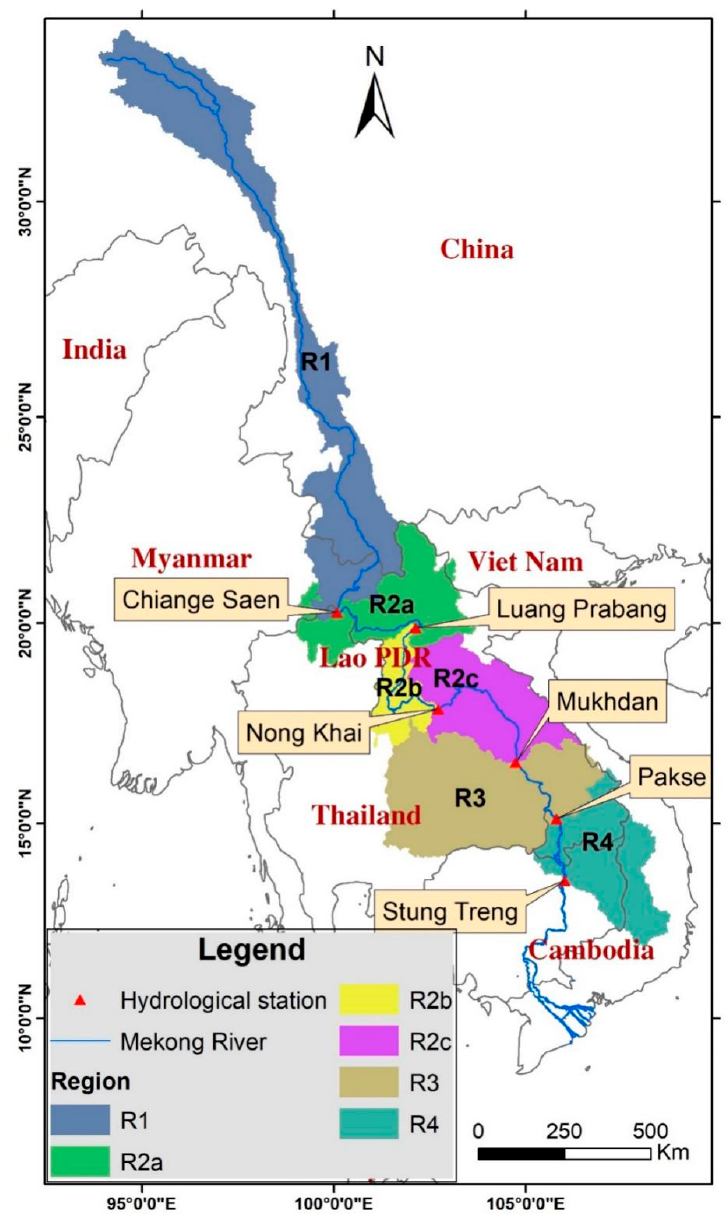
Figure 7. Sub-regions for the water balance analysis in the Mekong River Basin.